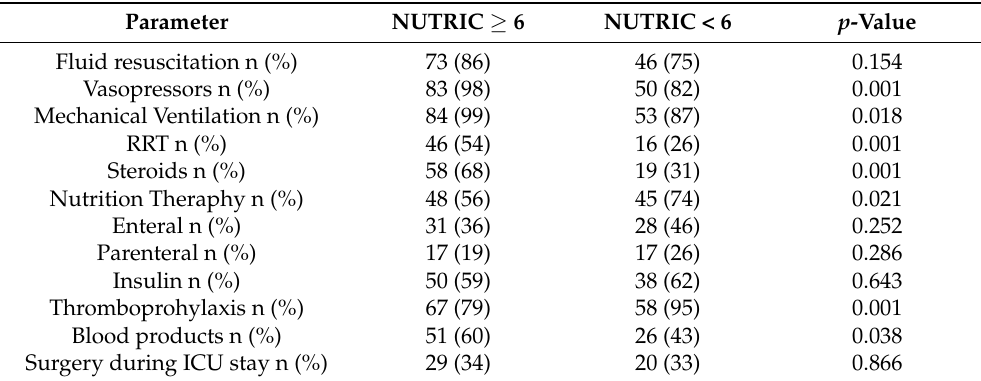
Table 4. Comparison of therapeutic resource requirements for treating septic patients with an mNUTRIC score < 6 and ≥ 6